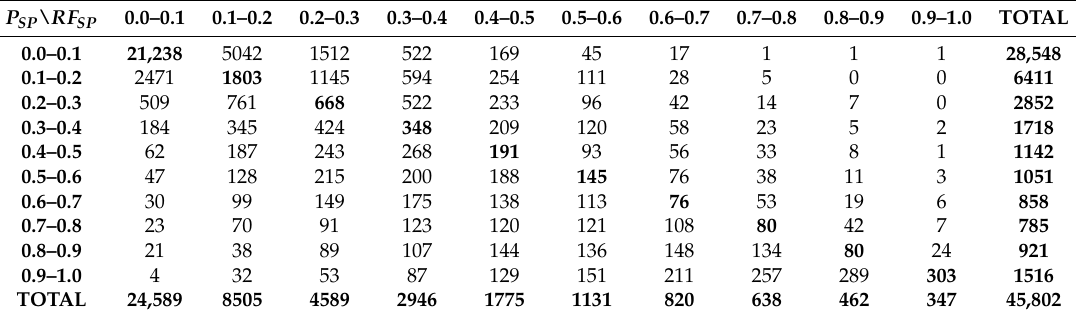
Table 5. Confusion Matrix of the best of our 10-fold cross-validated models. The rows represent the number of objects that have a GZ1 spirality between a specific interval. The columns represent how many of those our Random Forest predicted in the same and different intervals. Notice that these numbers are only for the test set, thus a total of 45,802 objects, which represent a more accurate measure of how our Random Forest would perform in real-world situations. The same data are depicted pictorially in Figure